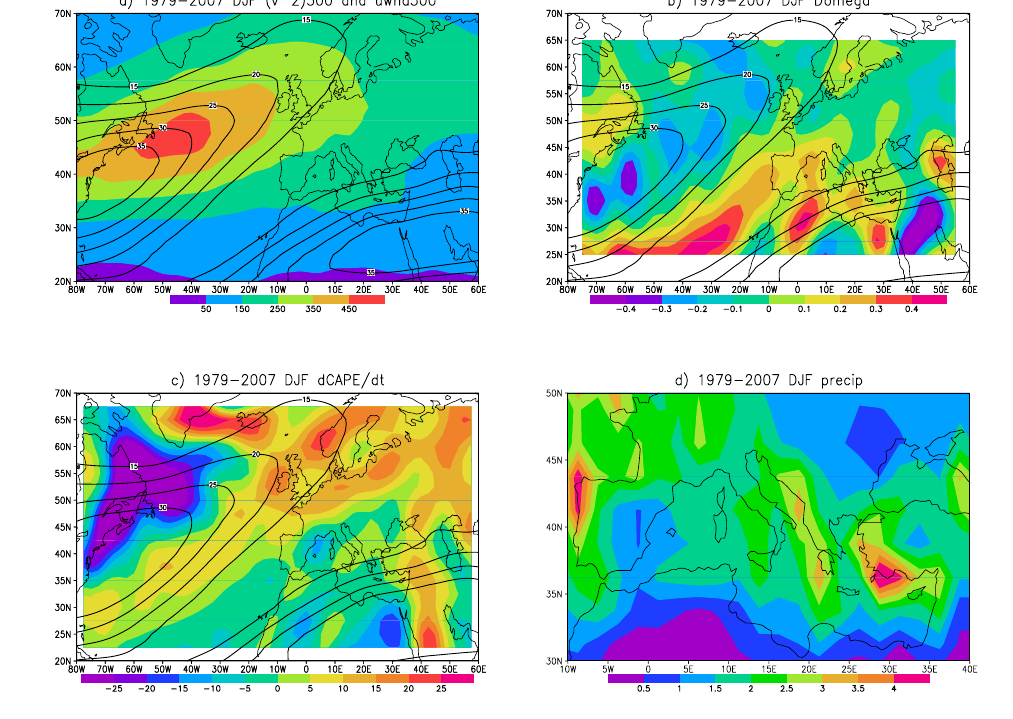
Fig. 7. Same as Fig. 5, but for winter.